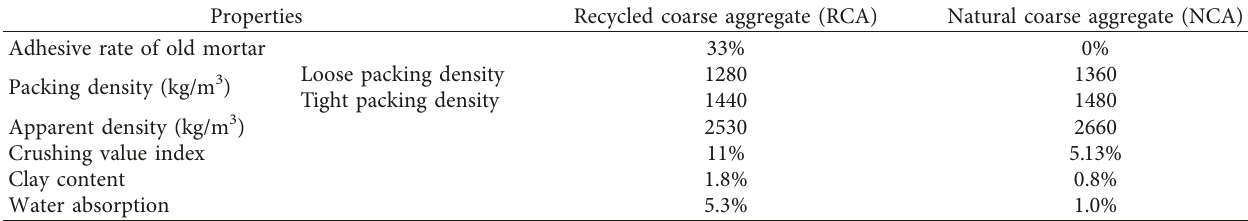
Table 1: Properties of RCA and NCA.